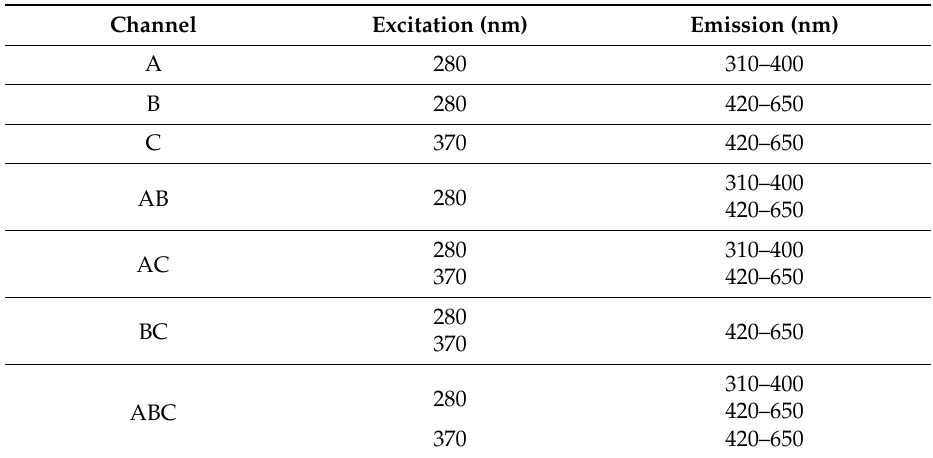
Table 3. Wideband Integrated Bioaerosol Sensor (WIBS) channel annotation matrix. Channels are matched with excitation wavelength and emission